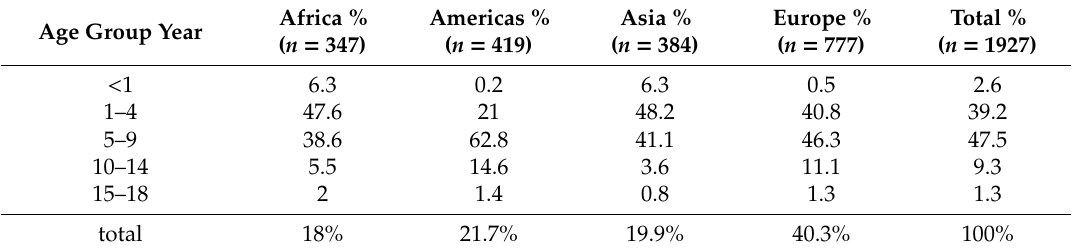
Table 2. Continent of origin of the internationally adopted children (IAC) referred to Meyer Children’s University Hospital, Florence, in the period (2009–2018), by age group (%).